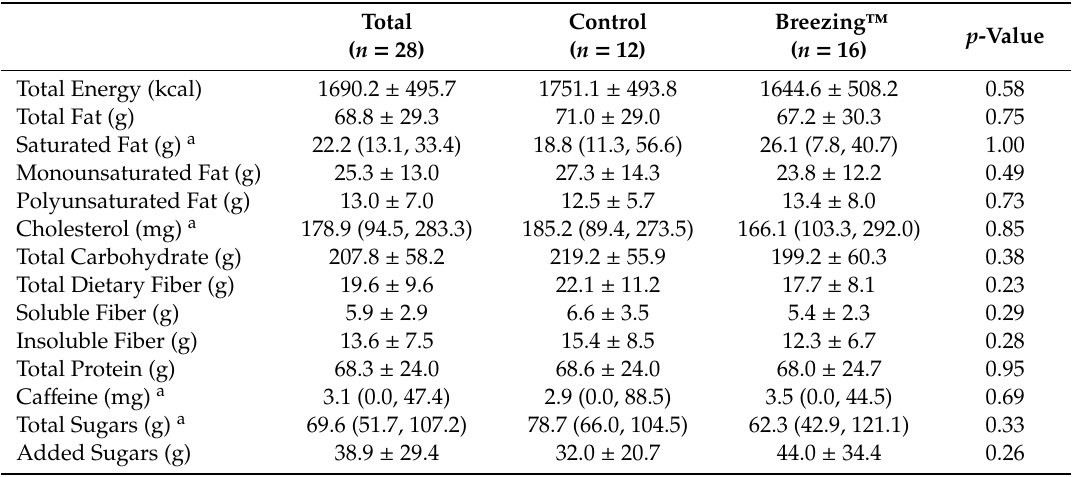
Table 3. Study Group Di ff erences in Baseline Maternal Daily Macronutrient, Fiber, Cholesterol, Ca ff eine, and Sugar Consumption at the Initial Study